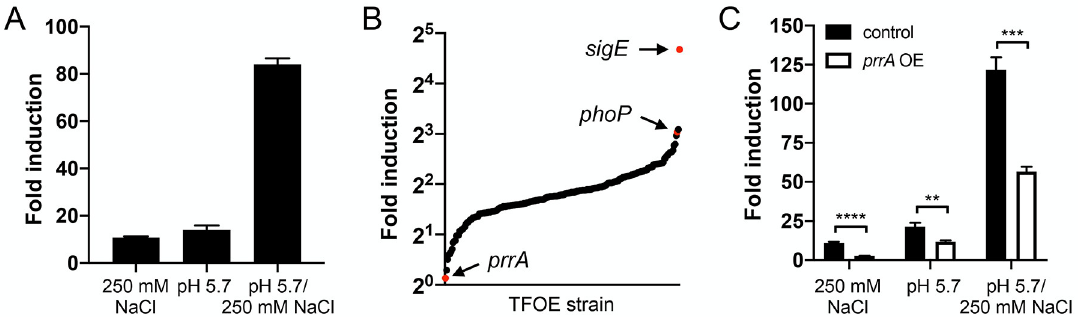
Fig 1. A rv2390c’ ::luciferase reporter transcription factor overexpression screen identifies PrrA as a TF that regulates Mtb response to pH and Cl - . (A) Mtb carrying a chromosomal rv2390c’ ::luciferase reporter was grown in 7H9, pH 7.0 ± 250 mM NaCl, or 7H9, pH 5.7 ± pH 250 mM NaCl for 9 days before light output (relative light units, RLU) and OD 600 were measured. Fold induction compares RLU/OD 600 in each condition to RLU/OD 600 in the control pH 7.0 condition. Data are shown as means ± SD from three experiments. (B) A library of inducible TF overexpression plasmids (P 1 ’:: TF -FLAG-tetON) in the background of a rv2390c’ ::luciferase reporter Mtb strain was screened for their response to 250 mM NaCl. TF overexpression was induced with 200 ng/ml ATC 1 day prior to exposure to 7H9, pH 7.0 ± 250 mM NaCl media for 9 days, in the continued presence of ATC. RLU/OD 600 was measured and fold induction calculated as in (A) for each strain. Empty vector plasmid controls were included for comparison. (C) prrA overexpression represses Mtb response to acidic pH and high [Cl - ]. Mtb(P 1 ’:: prrA -FLAG-tetON, rv2390c’ ::luciferase) was grown in 7H9, pH 7.0 ± 250 mM NaCl, or 7H9, pH 5.7 ± pH 250 mM NaCl for 9 days, with 0.1% ethanol (EtOH) as a carrier control (“control”) or 200 ng/ml ATC (“ prrA OE”) added 6 days post-assay start. RLU/OD 600 was measured at the end of the assay and fold induction calculated as in (A). Data are shown as means ± SD from three experiments. p-values were obtained with an unpaired t-test. �� p < 0.01, ��� p < 0.001, ���� p <